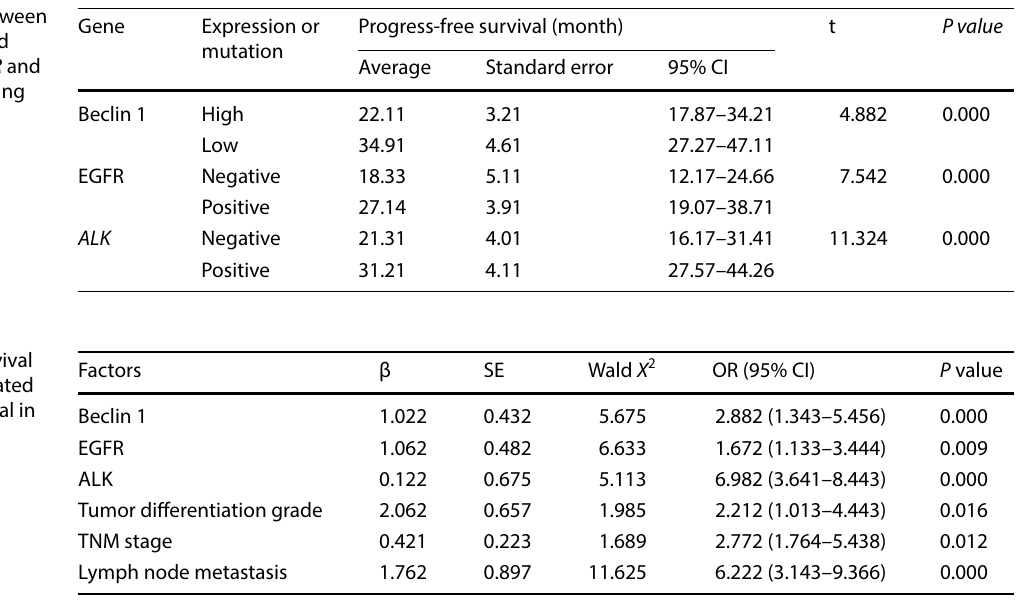
Gene Expression or Progress-free survival (month) mutation